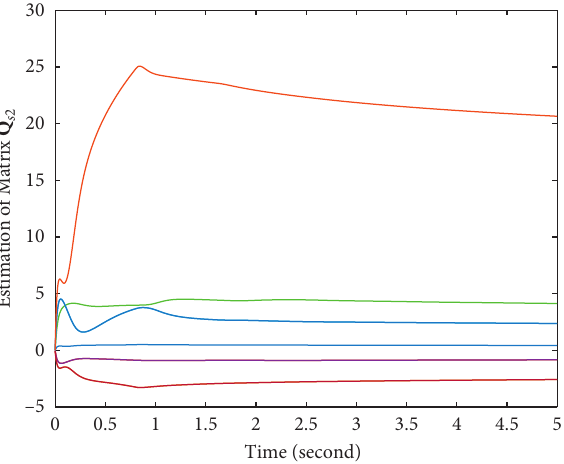
Figure 4: Estimated parameters for matrix Q